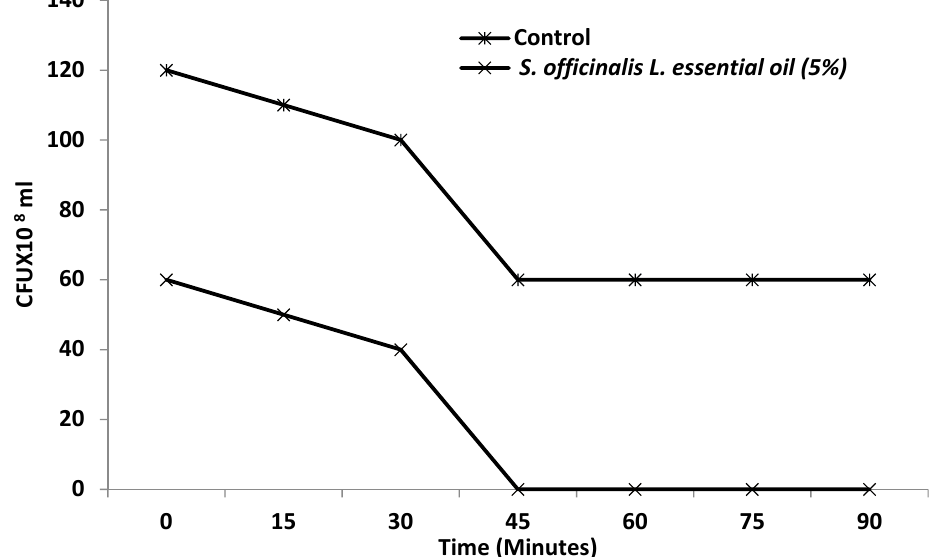
Figure 4. Effect of EO of S. officinalis at 5% v / v concentration on the viability of S. enterica . Values are the average of three individual replicates (means ±